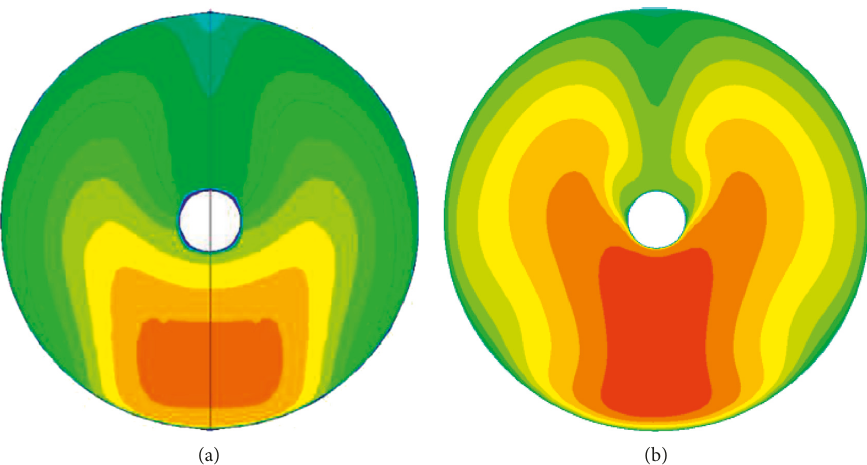
Figure 7: Comparisons between numerical and experimental results of the axial velocity distribution at inlet passage outlet. (a) Ex- perimental result (Bulten). (b) Numerical